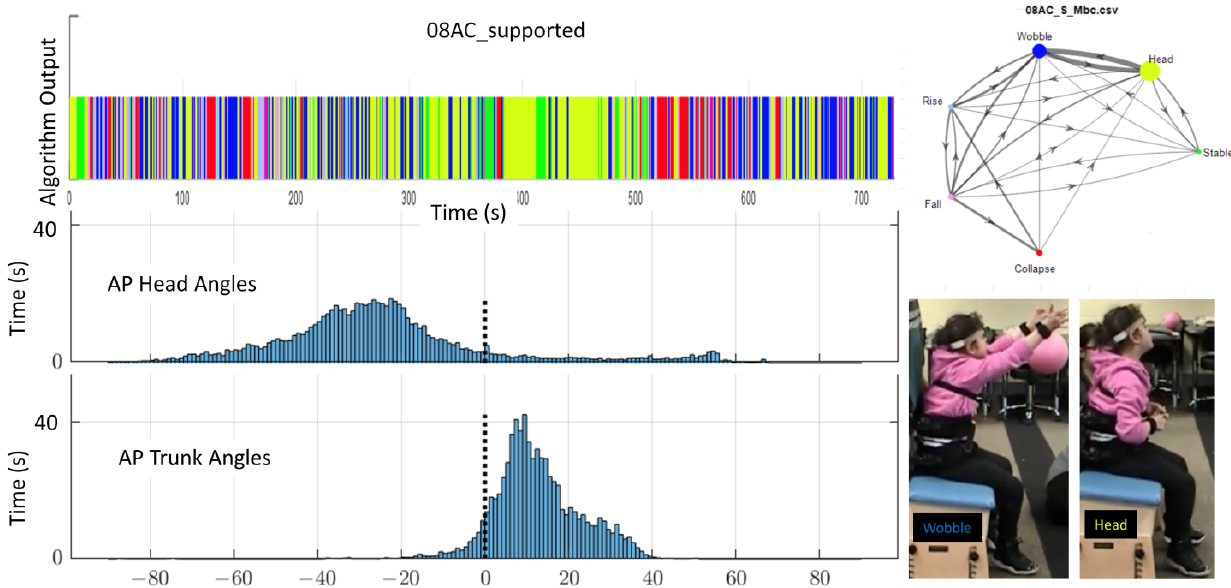
Figure 13. Example of algorithm output (colored bar) for the full 12 min, and AP histograms (bottom) and two images (right) showing AP alignment for 08AC during the LT support condition. The histogram is qualitatively consistent with Wobble and Head. Markov model (upper right) indicates stages (colored circles), amount of time spent in each stage (relative size of circles), transitions between states (lines with arrows), and frequency of transitions coming from each node (line thickness).